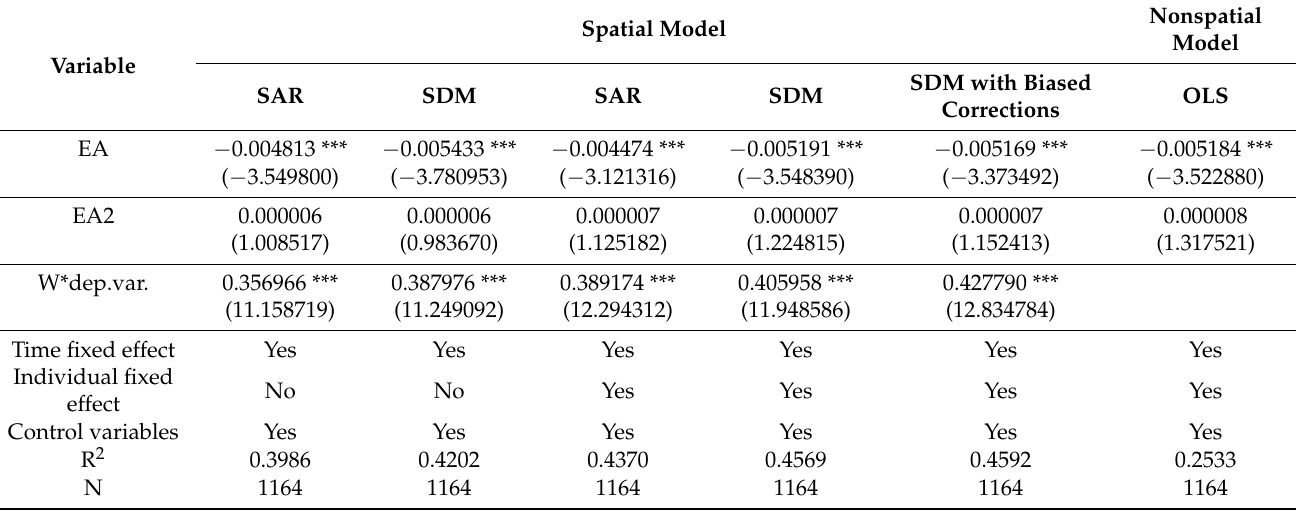
Table 6. Estimation results of SAR and SDM of robustness check.